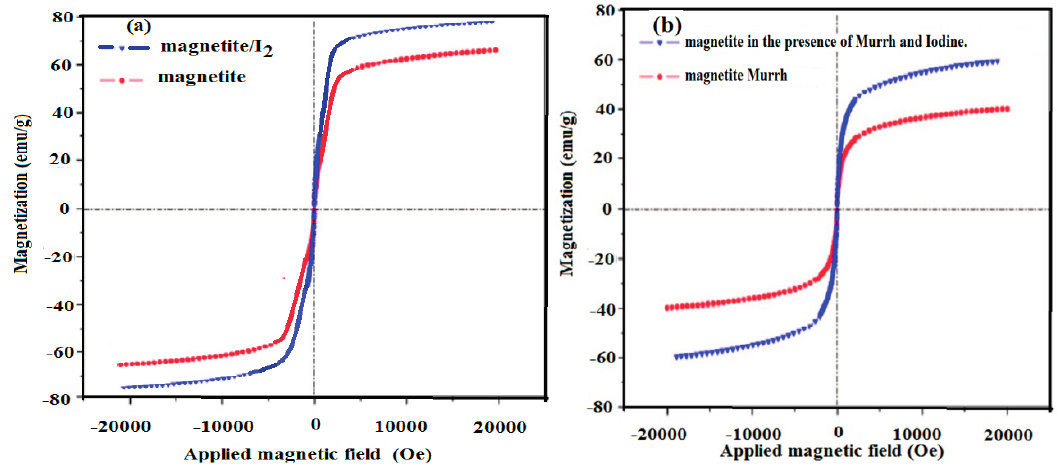
Figure 5. Hysteresis loop of the ( a ) magnetite prepared in the absence of myrrh and ( b ) presence of myrrh at 298